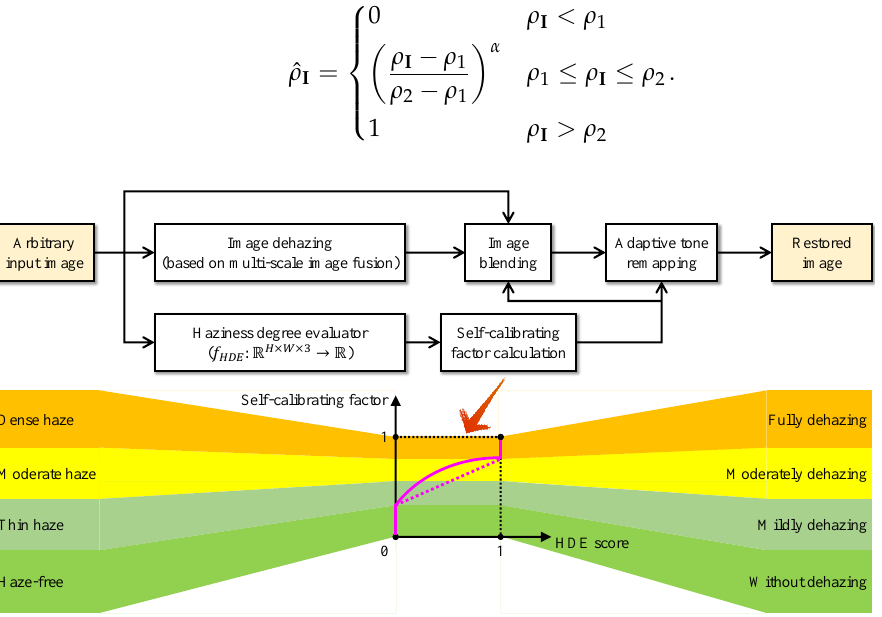
Figure 3. Block diagram of the autonomous dehazing algorithm in